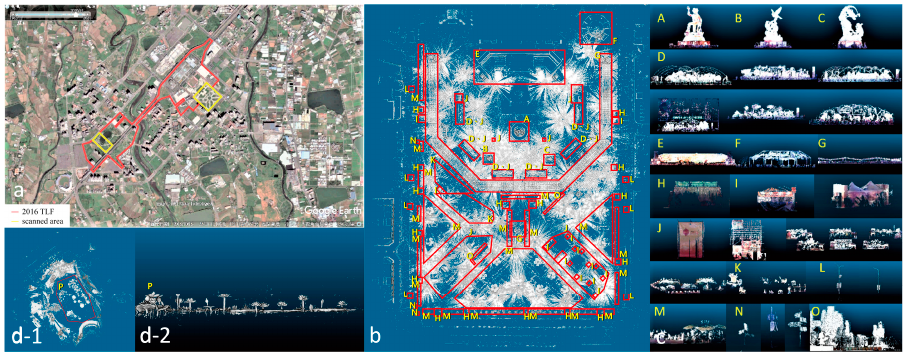
Figure 8. ( a ) Reconstructed festival scene and existing urban model, ( b-1 ) perspectives of the point-cloud model in plain mode, ( b-2 ) a closer view of the model details, ( c ) perspective of the point cloud in original color, and ( d ) elevation with the presentation of crowds at ground level.